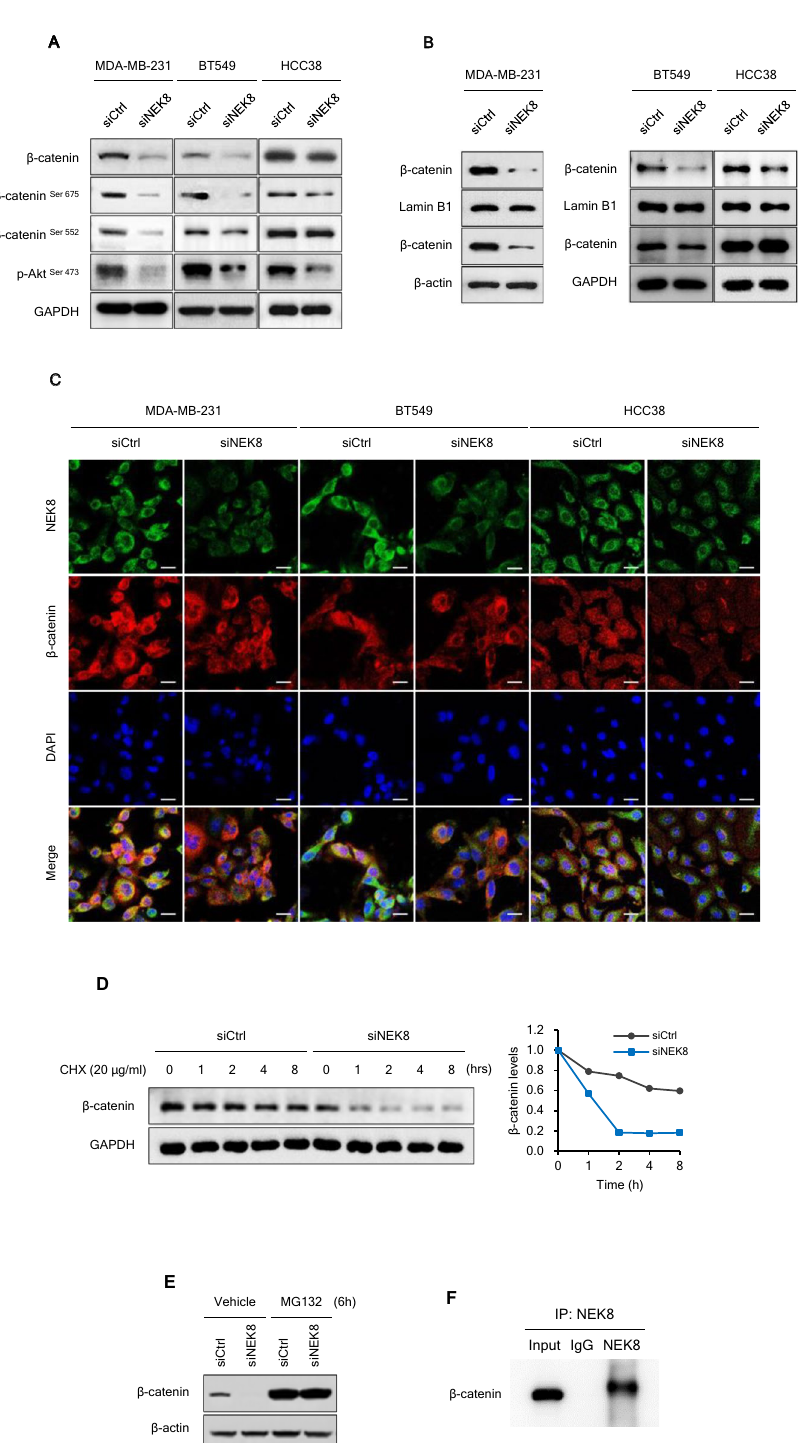
Figure 5. Knockdown of never in mitosis gene A-related kinase-8 (NEK8) inhibits β-catenin signalling in breast cancer cells. ( A ) The expression of total β-catenin, phospho-β-catenin S675 , phospho-β-catenin S552 , and phospho-AKT S473 in breast cancer cells transfected with NEK8-silencing (siNEK8) was detected using western blotting. ( B ) Representative western blot images demonstrating subcellular localisation of β-catenin in the nucleus and cytosol. ( C ) Confocal micrographs showing decreased nuclear β-catenin levels in MDA-MD-231, BT549, and HCC38 cells treated with siCtrl or siNEK8 for 72 h. GAPDH and β-actin were used as loading controls for whole cell lysates, and Lamin B was used as a loading control for nuclear fractions. The figure is representative of at least three independent experiments that showed similar results (n ≥ 3). ( D ) Stabilisation of β-catenin in NEK8 knockdown cells. The cells were treated with cycloheximide (CHX; 20 μg/mL) and collected at the indicated times for western blotting. ( E ) The cells were untreated or treated with MG132 (5 μM) for 6 h, and then subjected to western blotting. ( F ) Co-immunoprecipitation analysis of the interaction between NEK8 and β-catenin in MDA-MB-231 cells. The blots were cut prior to incubation with